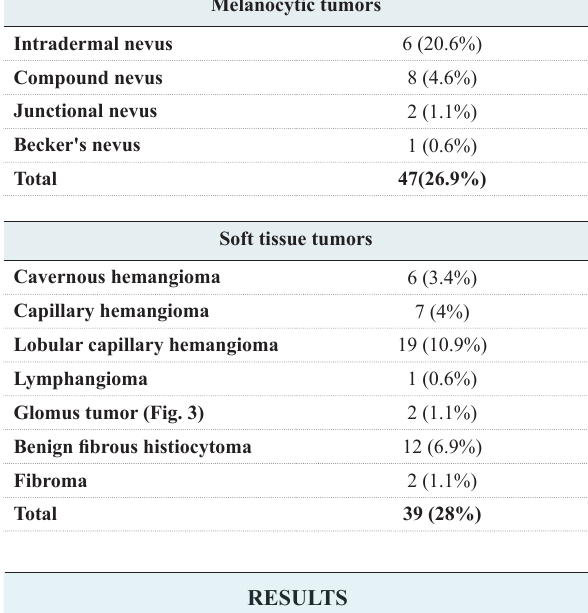
Table 2: Histomorphological patterns of benign skin